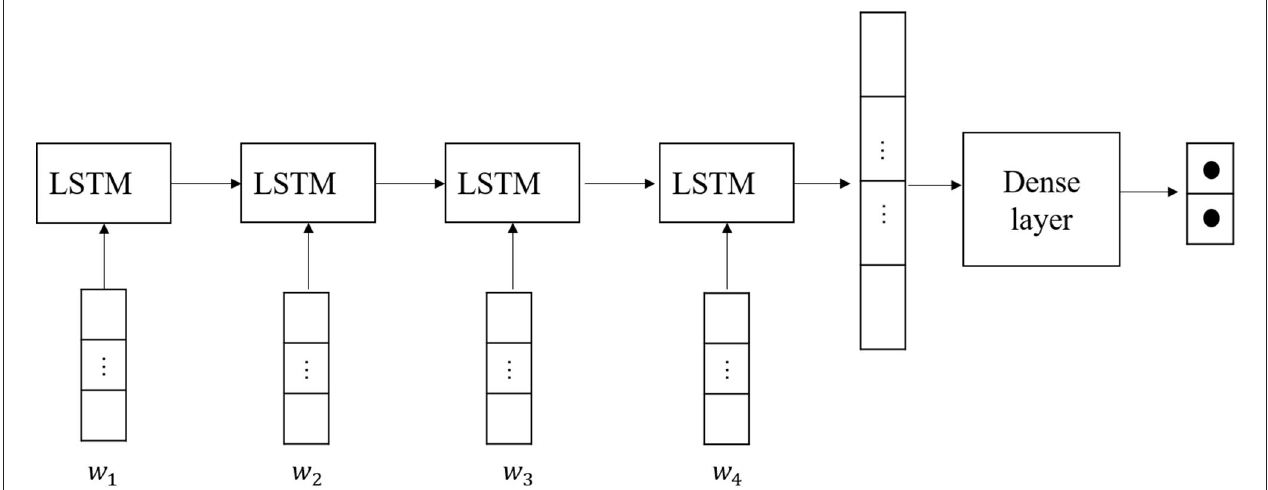
FIGURE 4 | The architecture of long short-term memory